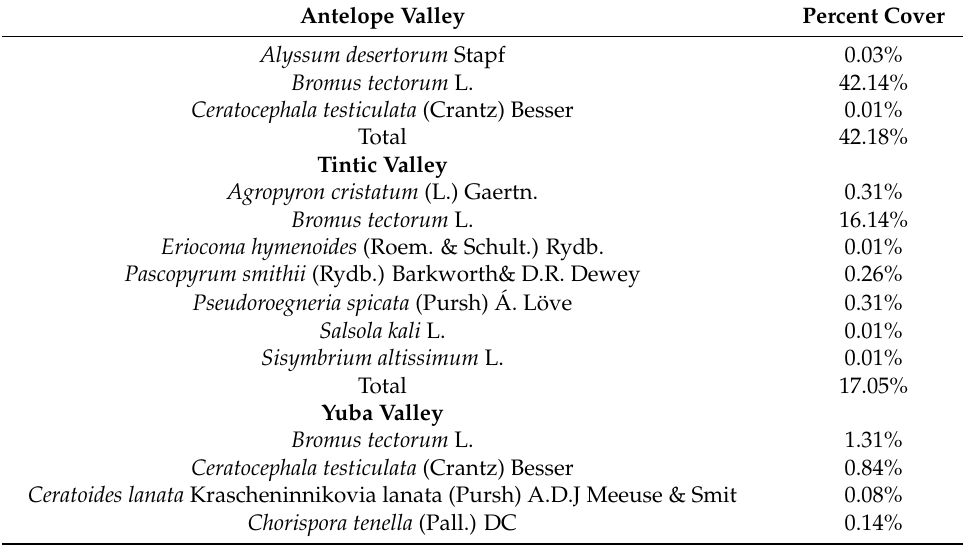
Table 2. Species Composition in Cheatgrass Habitat Type. Antelope Valley Percent Cover